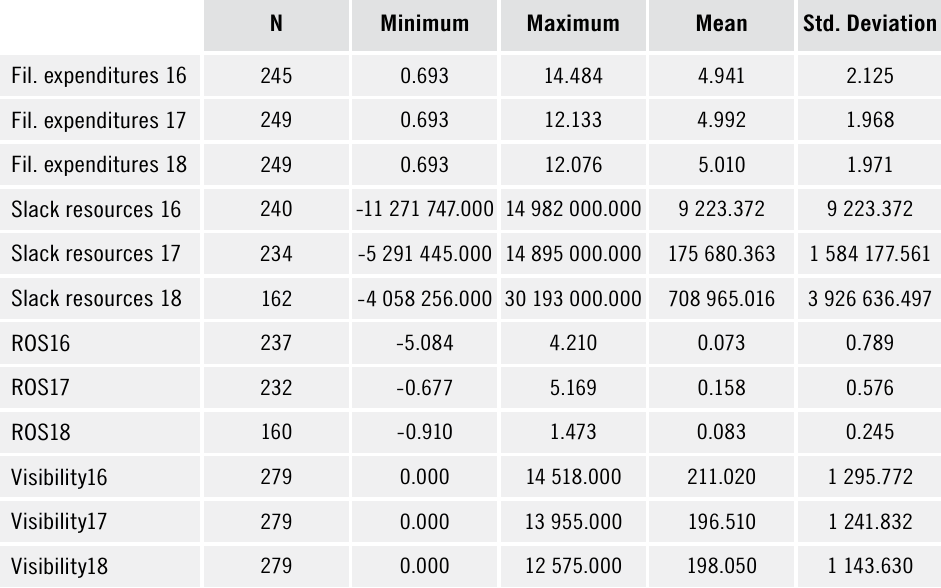
Table 3. Overview of descriptive statistics: continuous